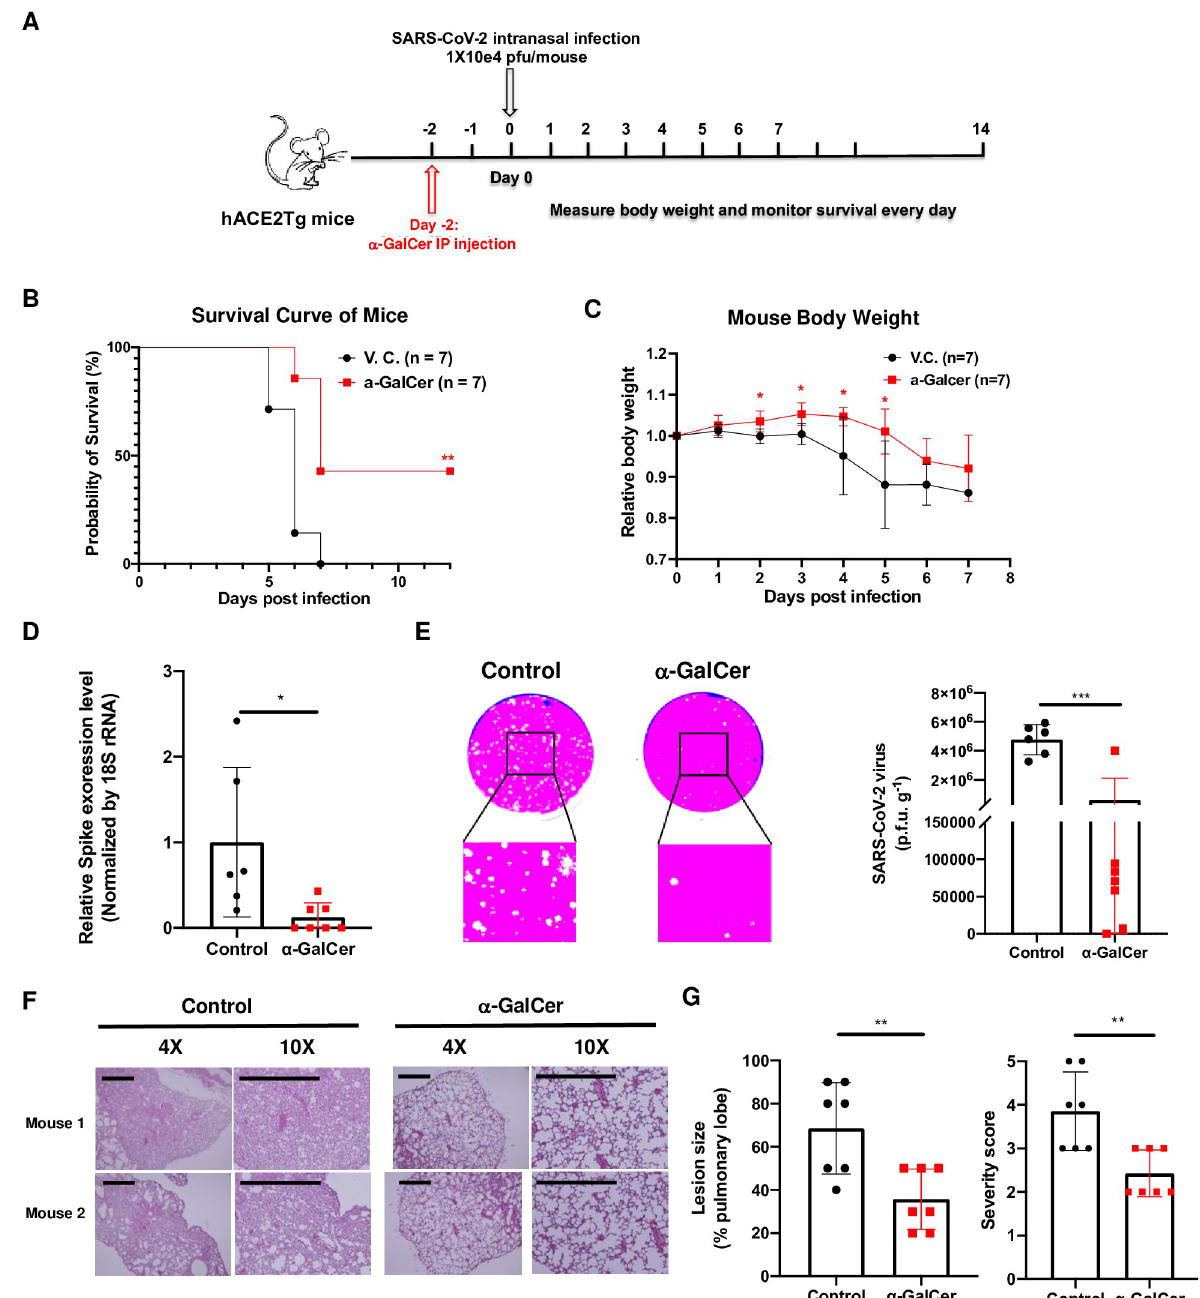
Fig 8. iNKT cell activation overcomes SARS-CoV-2 immune suppression of NKT cell function, mitigates disease severity and improves host survival in mice. (A). A schematic presentation of SARS-CoV-2 infection in mice. (B, C). K18-hACE2-Tg mice (n = 7 per group) were administered once with α -galactosylceramide ( α -GalCer, 2 μ g per mouse) and two days post treatment, were intranasally infected with SARS-CoV-2 (Isolate USA-WA1/2020, 1X10e4 pfu per mouse). (D-G). iNKT cell activation reduced viral replication and disease severity in lung tissues. (D). Local virus replication analyzed by real-time PCR for mRNAs of viral spike proteins using lung tissue RNA samples on day 3 (n = 6 for control group and n = 7 for α -GalCer-treated group) from infected K18-hACE2-Tg mice untreated (control) or pre-treated with α -GalCer 2 days prior ( α -GalCer). (E). Titration of local viral load by plaque assays using the supernatant of homogenized lung tissues on day 3 (n = 6 for control group and n = 7 for α - GalCer-treated group). (F). Histopathology analysis of formalin-fixed and hematoxylin and eosin (H&E)-stained lung tissues (n = 7 per group). (G). Comparison of pulmonary lesion sizes and pathological severity scores in vehicle control and α -GalCer-treated mouse groups (n = 7 per group), based on the percentage of affected area in lung tissues (see “Materials and Methods”). Representative images of plaque assay (E) and H&E staining (F) were presented. Scale bar, 250 μ m (F). B-G were representative data from three independent experiments and relative body weight (C) was